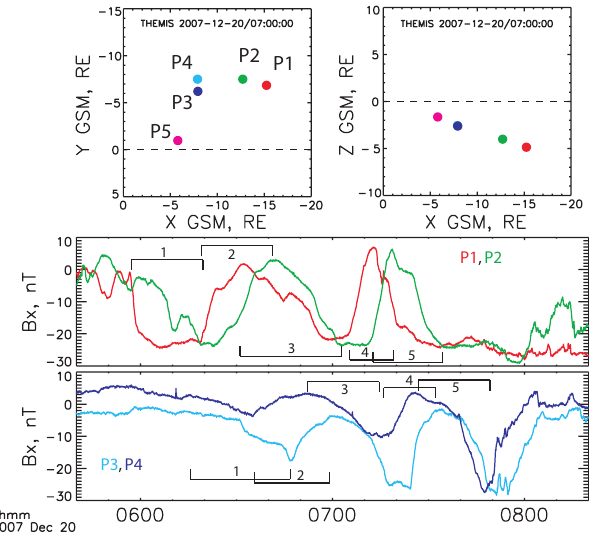
Fig. 3. Positions of THEMIS spacecraft XY and XZ , GSM planes at 07:00UT on 20 December 2007 (top panel); The X-component of the spin-averaged magnetic field measured by P1 and P2 (mid panel) and P3 and P4 (bottom panel) between 05:40 and 08:20UT on 20 December